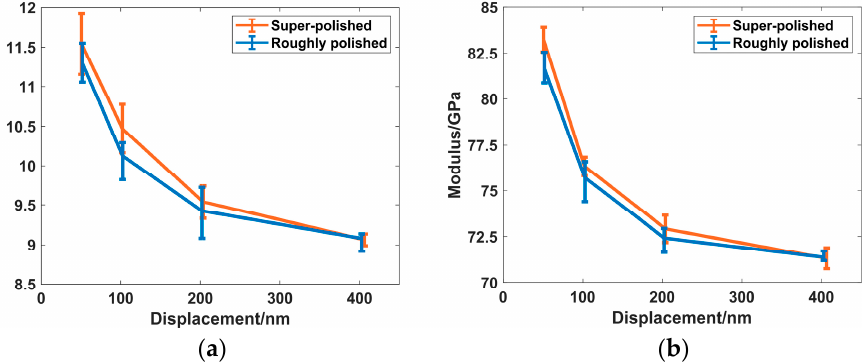
Figure 3. Comparison of mechanical properties of super − polished and roughly polished samples tested by the static indentation method: ( a ) hardness; ( b ) modulus.